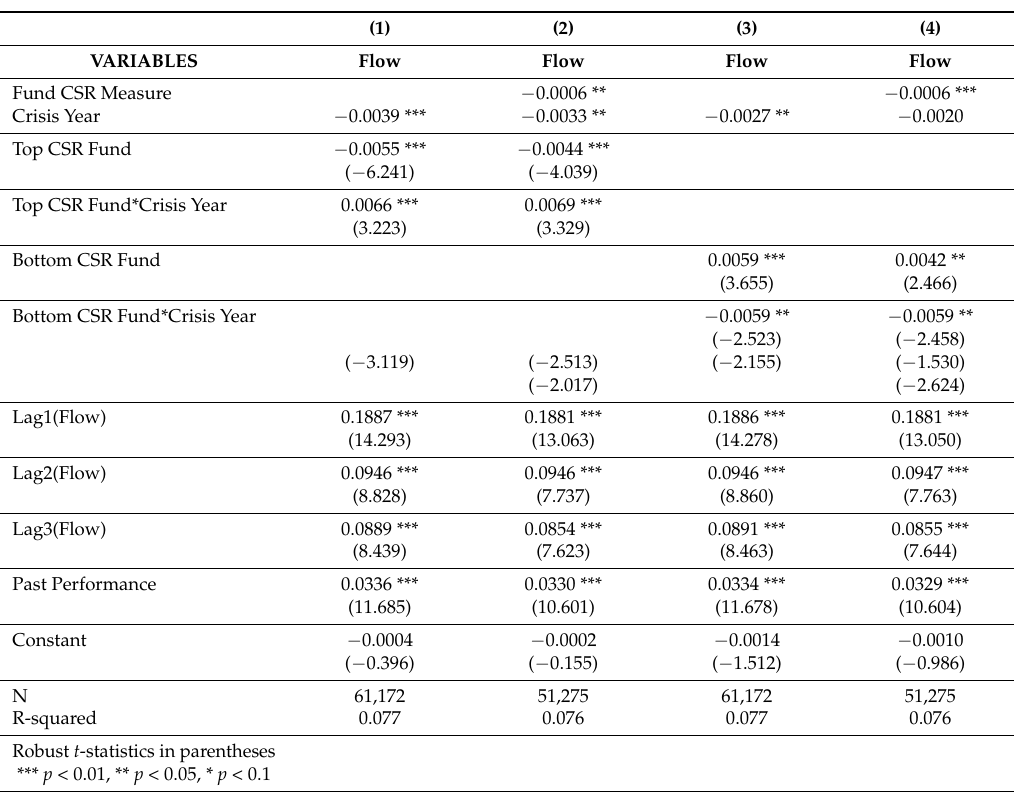
Table 4. CSR-funds and new investments: financial crisis versus non-crisis subsample